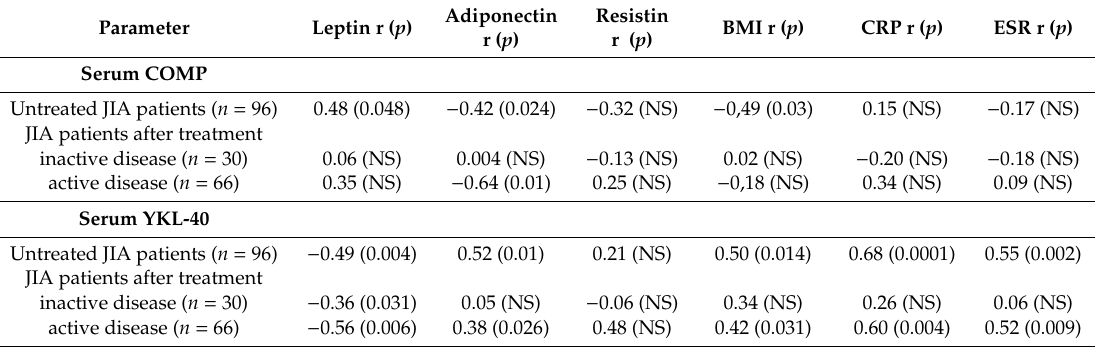
Table 2. Correlation analysis between serum cartilage oligomeric matrix protein (COMP) and human cartilage glycoprotein-39 (YKL-40) with leptin, adiponectin, resistin, BMI, C-reactive protein (CRP), and erythrocyte sedimentation rate (ESR)